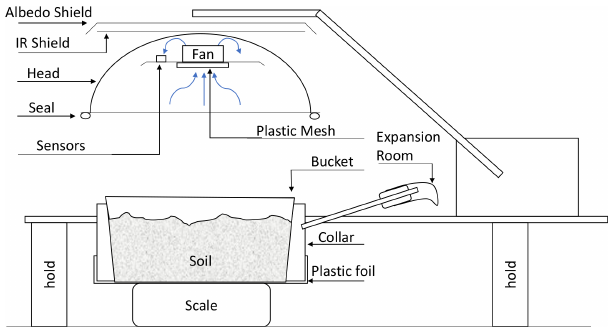
Figure 1. Scheme of the chamber and experimental setup. In this sketch, the chamber head is not